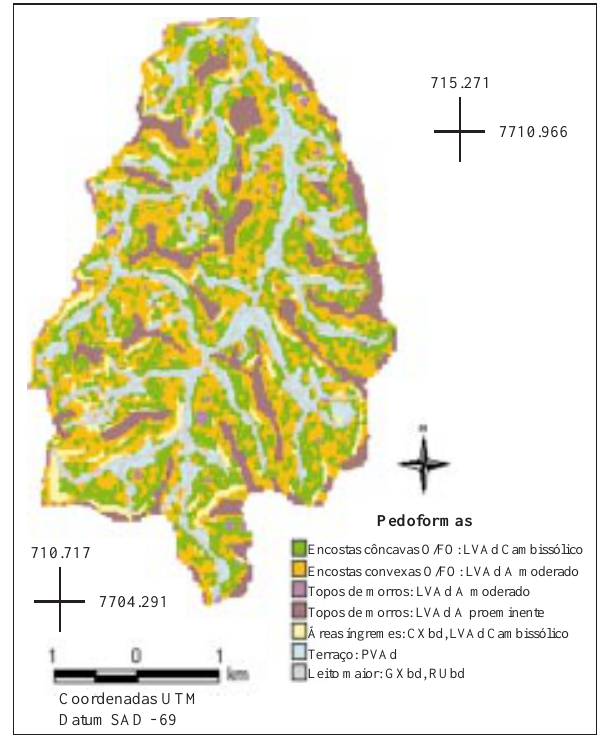
Figura 5. Classificação de pedoformas da bacia do Córrego Ipiúna. O/FO: Relevo ondulado e fortemente